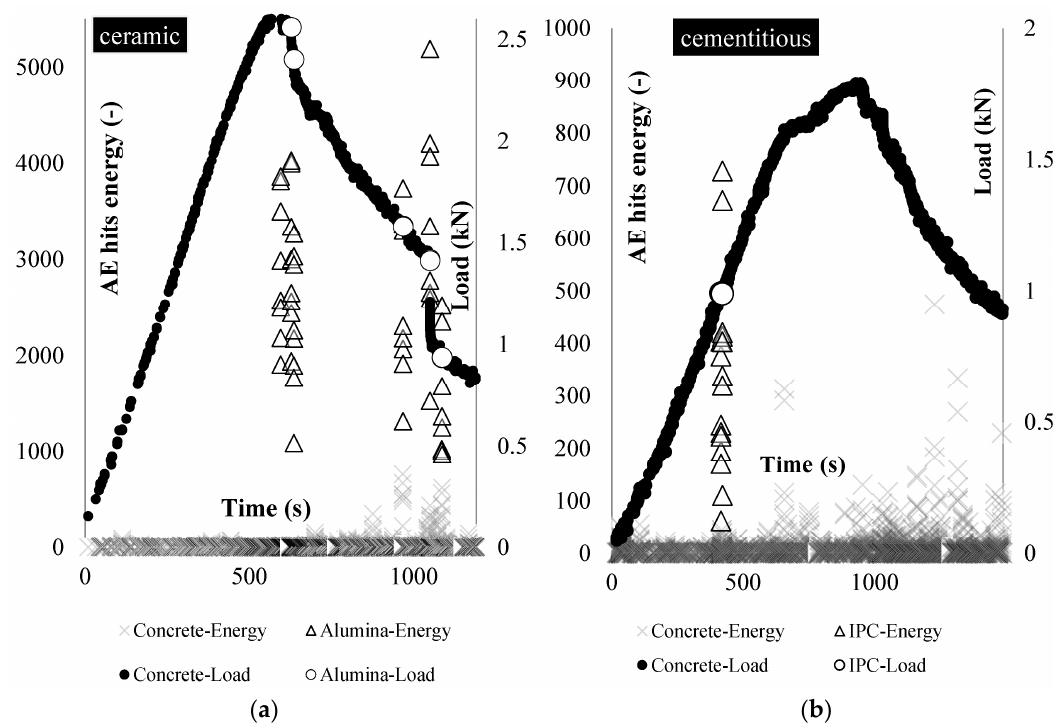
Figure 4. Beams carrying: ( a ) ceramic; and ( b ) cementitious piping network tested under three-point- bending: the load (black points) and the tubes rupture location (red points) based on AE energy analysis (triangular shapes).